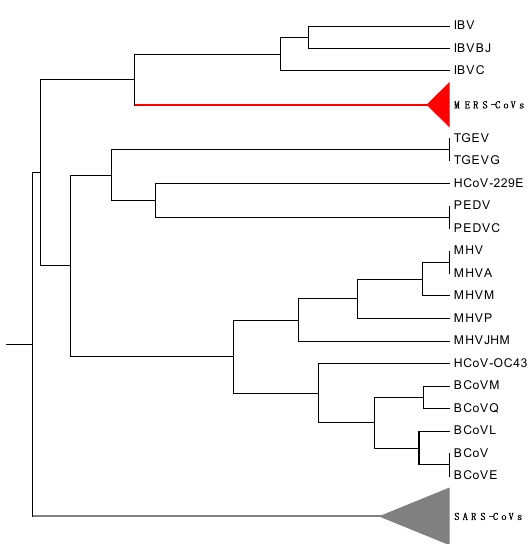
Figure 4. The relationship tree of the coronavirus spike proteins with the 27 ‐ D vector. Table 7. Results of the three cross ‐ validation tests with the 27 ‐ D vector.